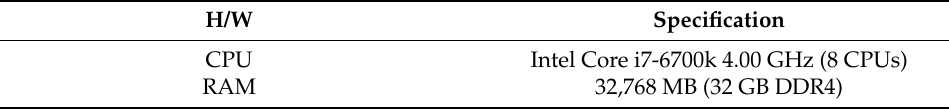
Table 1. Computer performance for